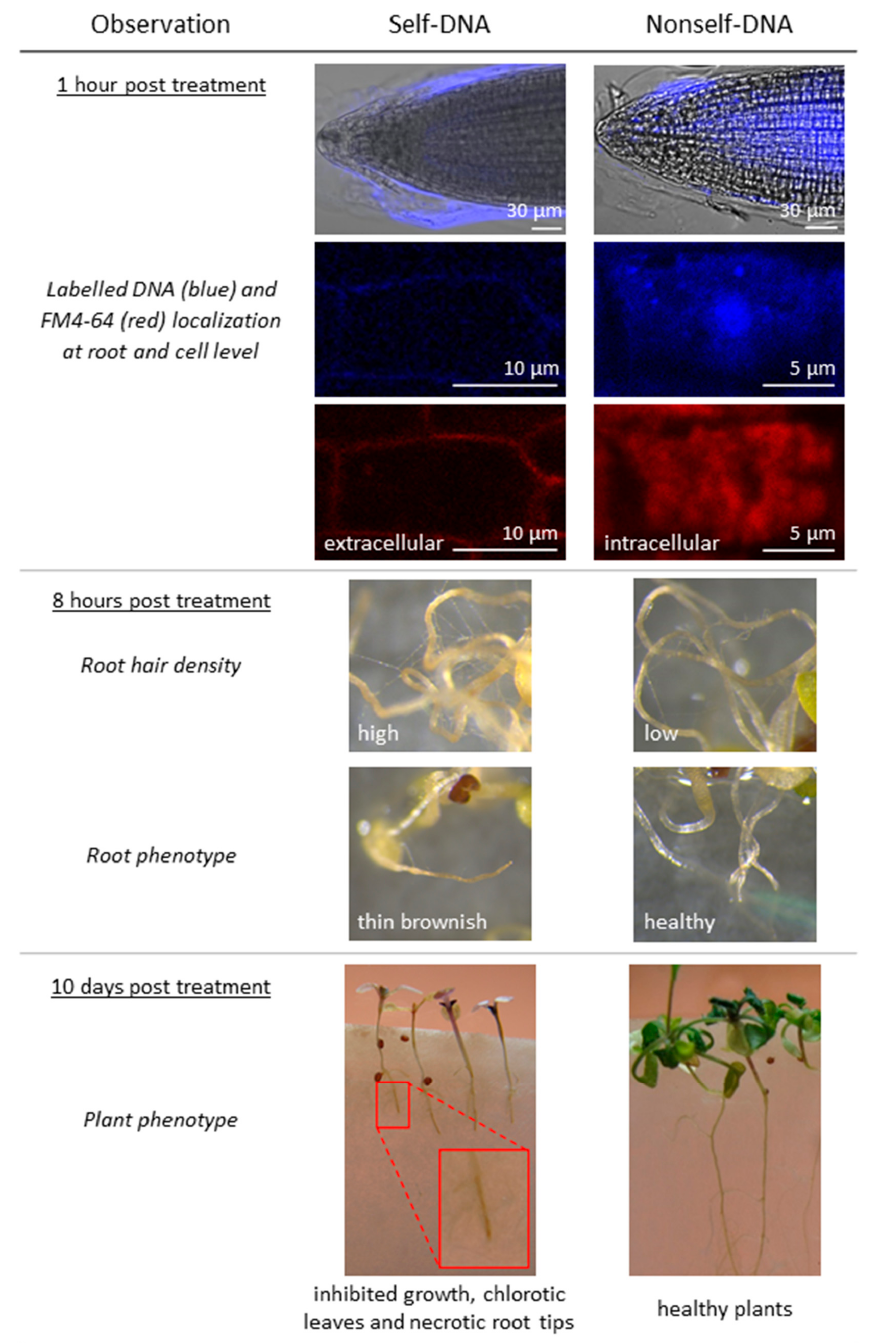
Figure 6. Summary of the main differences in response to extracellular self- and nonself-DNA in plants. A differential uptake according to treatments is clear after 1 h, morphological differences on thin roots and root apices appear after 8 h, full inhibition by the exposure to self-DNA is evident on the whole plants after 10 days.